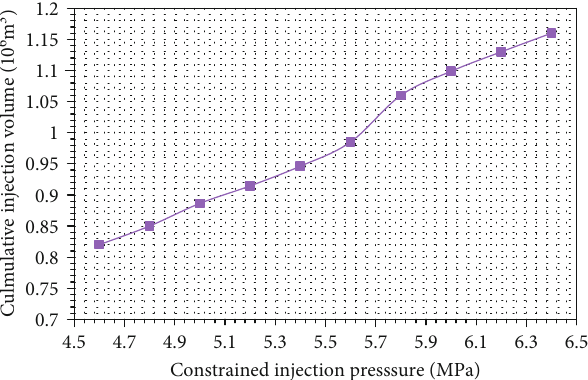
Figure 8: Cumulative injection volume under di ff erent constrained injection pressures for 360